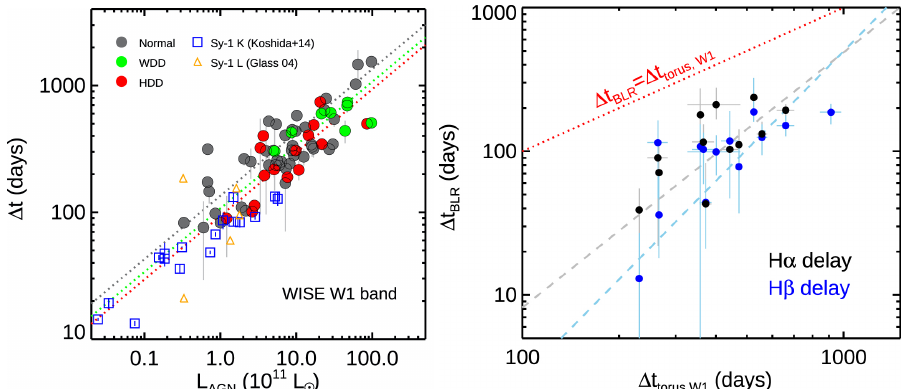
Figure 12. Left : The optical-to-mid-IR time-lag ( ∆ t ) scales with the AGN luminosity as ∆ t ∝ L 0.5 . AGN Here, the filled symbols correspond to WISE 3.4 µ m light curves for quasars, whereas the open symbols correspond to literature measurements in the K-band for Seyferts. The measured lag implies a size of the λ rest 3–4 µ m dust emitting region to be 0.3pc for an L AGN 10 12 L quasar. Right : ≈ ≈ ∼ (cid:12) Comparison with the time lags to the BLR suggests that this mid-IR emitting dust is roughly 4 × further away than the radius of the BLR. Reproduced with permission from Lyu et al. [29], AAS ©